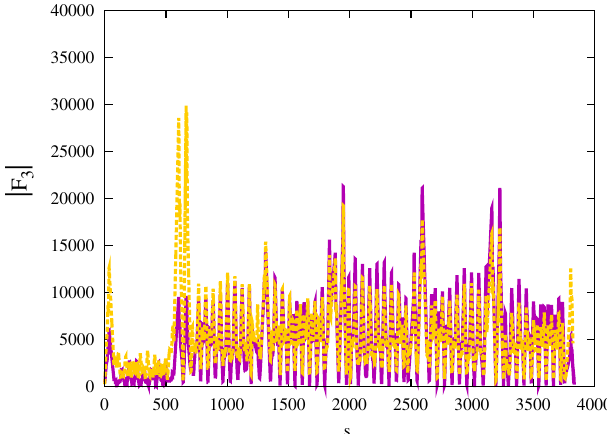
j around the circumference of Þ at 100 GeV in the drift space FIG. 1. (Color) Graph of j F FIG. 3. (Color) Graph of arg ð F 3 3 RHIC. The origin is at 6 o’clock (STAR). The rotators are L232 of RHIC for three scenarios: (a) solid (purple)—no rota- switched off, in this calculation. The solid curve is with tors; (b) dashed (green)—longitudinal polarization at both STAR Snakes on. The dashed curve is with Snakes off. The beam and PHENIX; (c) dot-dashed (red)—no rotators at STAR, radial energy is slightly more than 100 GeV, so that the fractional spin polarization at PHENIX. The horizontal axis shows the arclength tune is 0.5 in both curves. in meters, measured from the 6 o’clock